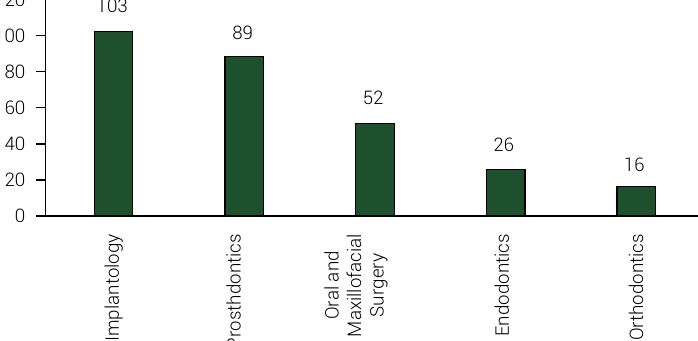
Figure 2. Dental specialties in lawsuits against dentists involving dental malpractice litigance, 2012-2017, São Paulo, SP, Brazil.